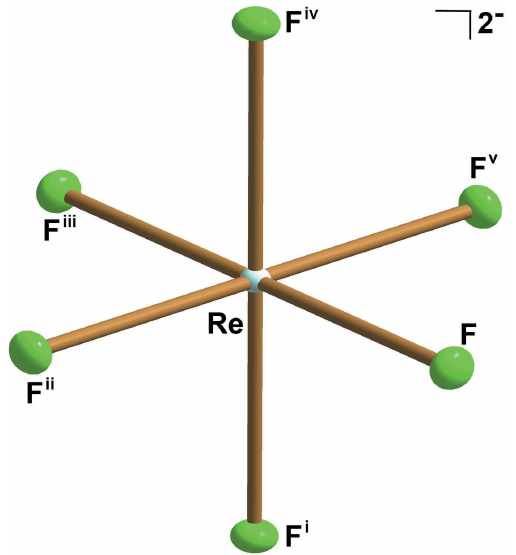
Figure 1 Representation of the [ReF 6 ] 2 (cid:2) anion in Cs 2 [ReF 6 ]. Displacement ellipsoids are drawn at the 50% probability level. [Symmetry codes: (i) (cid:2) x , (cid:2) y , (cid:2) z ; (ii) x (cid:2) y , x , (cid:2) z ; (iii) (cid:2) x + y , (cid:2) x , z ; (iv) (cid:2) y , x (cid:2) y , z ; (v) y , (cid:2) x + y , (cid:2) z